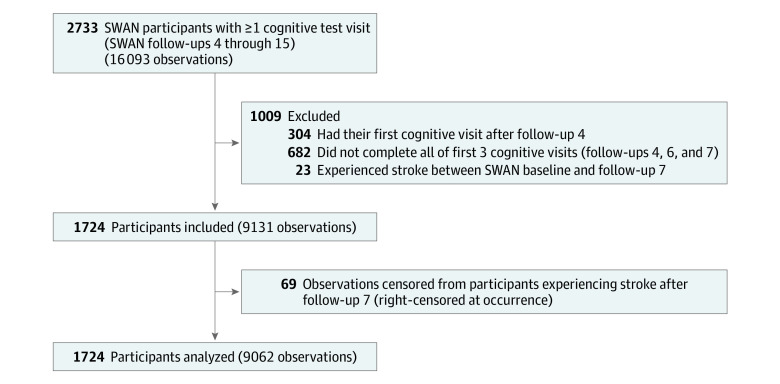
Derivation of the Analysis SampleSWAN indicates the Study of Women’s Health Across the Nation.